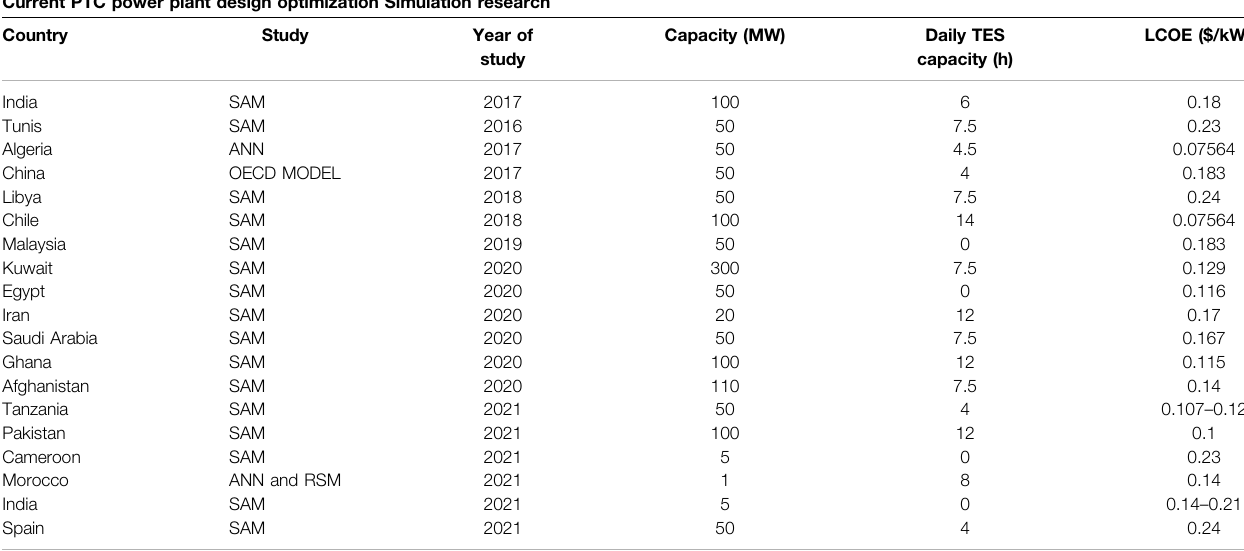
TABLE 1 | Current PTC power plant design optimization simulation research (Zineb et al., 2021). Current PTC power plant design optimization Simulation research Country